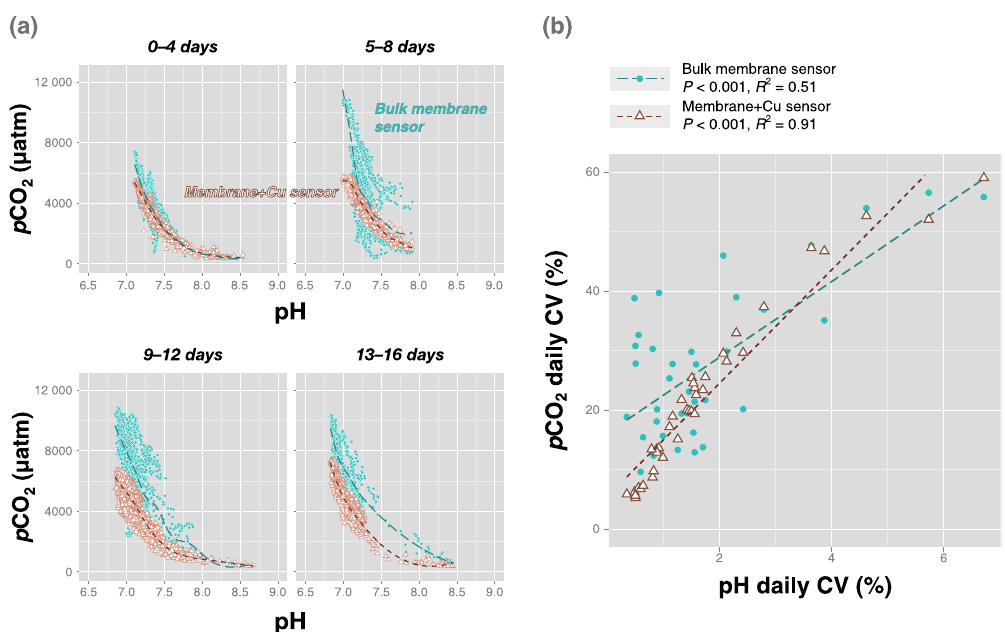
Figure 7. (a) The relationship between pH and p CO 2 during successive 4-day monitoring periods following maintenance; (b) the relationship between daily coefficient of variations (CVs) of pH and p CO 2 . Membrane-enclosed sensors without and with copper mesh screen are indicated by bulk membrane and membrane + Cu, respectively. Curves were fitted using LOESS (locally weighted scatter plot